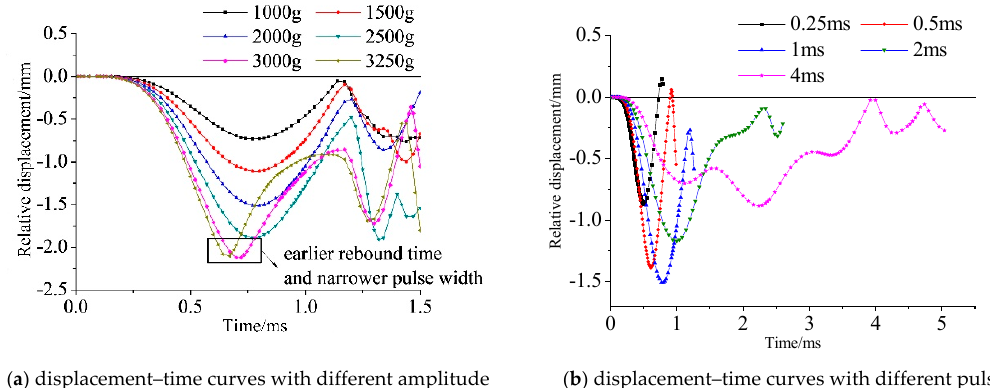
Figure 7. Simulated displacement–time curves of a rotor under impact with a different amplitude and duration.